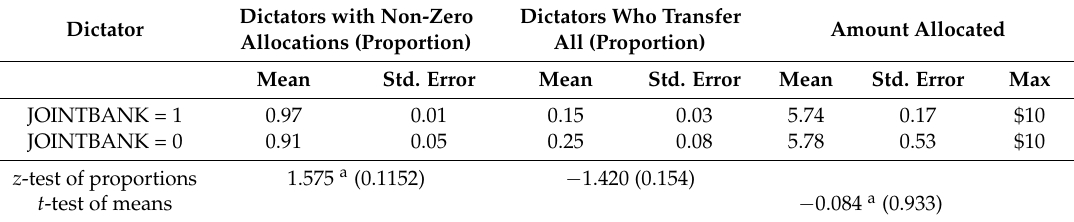
Table 4. Allocation of $10, based on JOINTBANK.